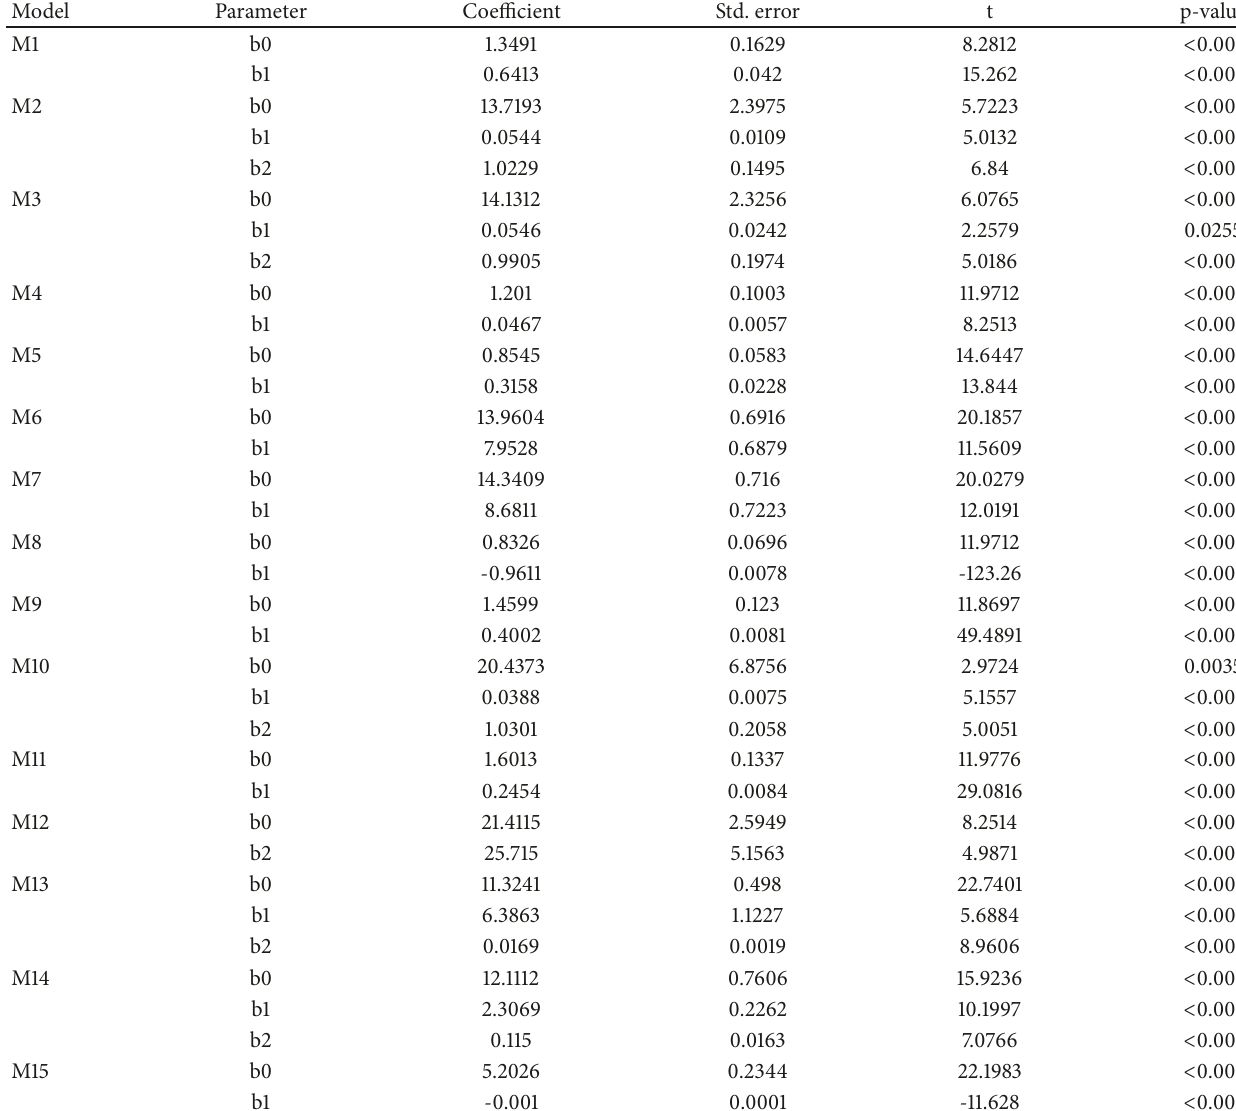
Table 3: Parameter estimates of the selected